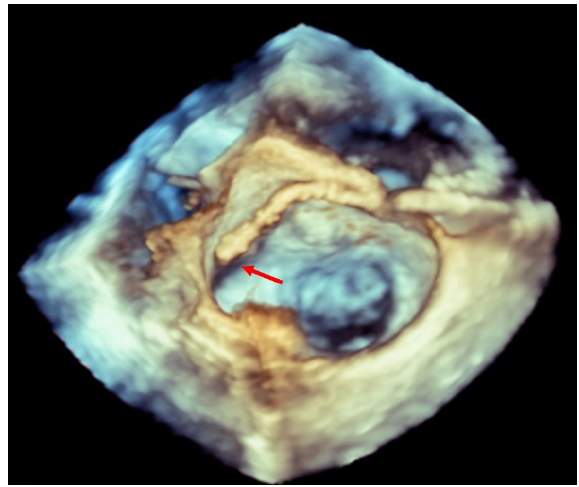
Figure 1. Three-dimensional transesophageal echocardiogram showing a clip inside the left atrium touching the lateral wall (red arrow).